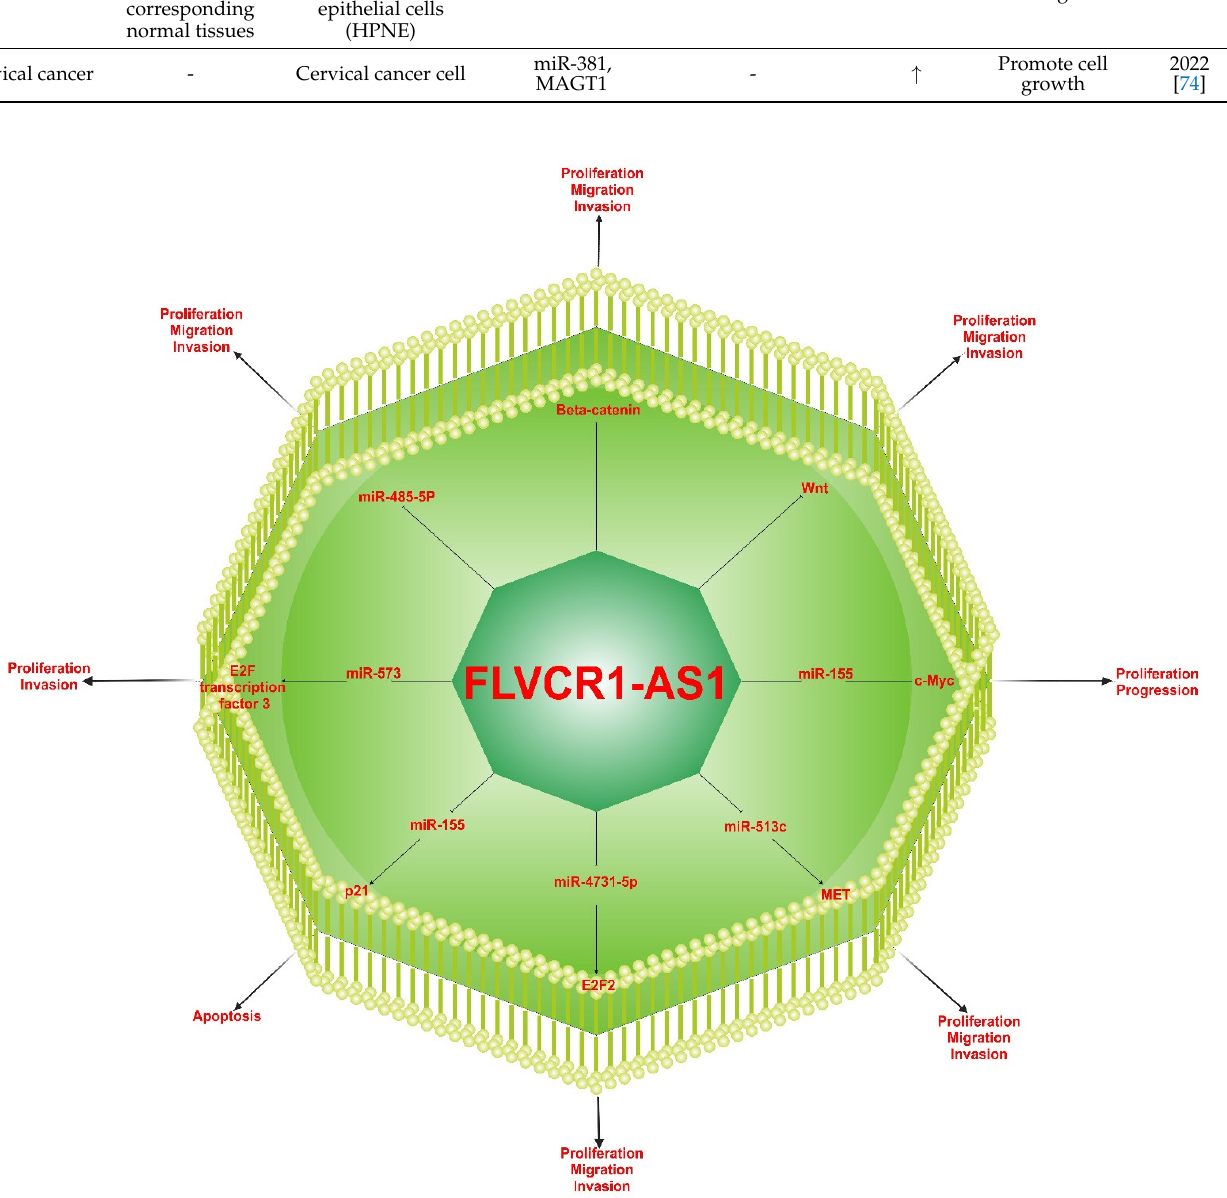
Figure 5. Underling molecular mechanisms of FLVCR1-AS1.